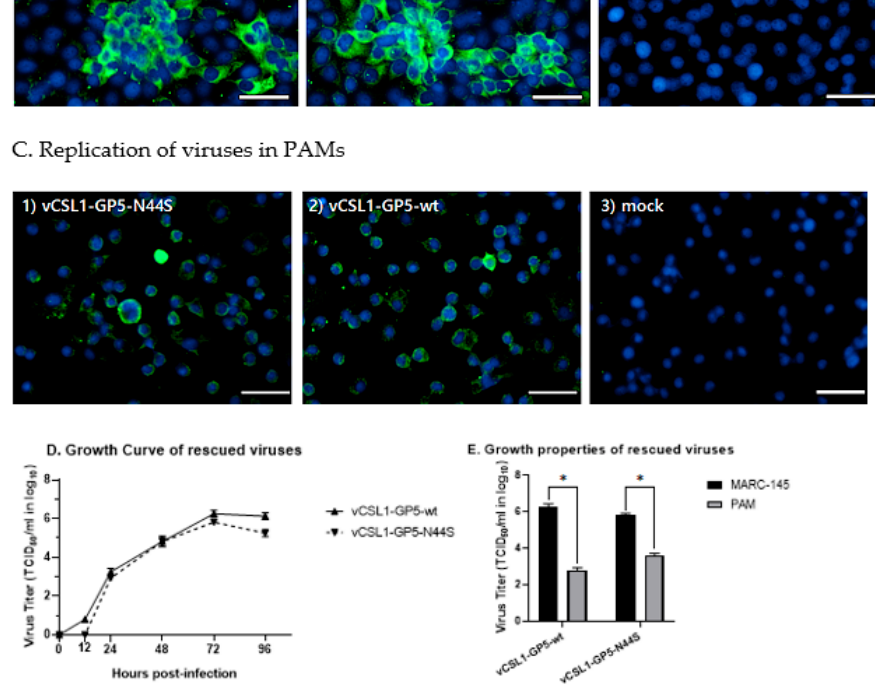
Figure 1. Introduction of mutations in GP5 protein and comparison of replication characteristics with backbone viruses. ( A ) The amino acid sequence alignment of GP5 protein between the backbone virus, vCSL1-GP5-wt, and the novel virus, vCSL1-GP5-N44S. The 44th substitution site is indicated by a yellow band. ( B , C ) Replication of mutant virus detected using indirect immunofluorescence assay in MARC-145 cells or PAM cells. The green signal is PRRSV, the blue signal is the nucleus, and the white band represents the 50 µm scale. ( D ) Comparison of the one-step growth curves of the backbone and novel viruses in MARC-145 cells. ( E ) Comparison of maximal titers of backbone and novel viruses in MARC-145 and PAM cells 72 h after inoculation. The symbol “*” indicates statistically significant differences (* p ≤ 0.05).